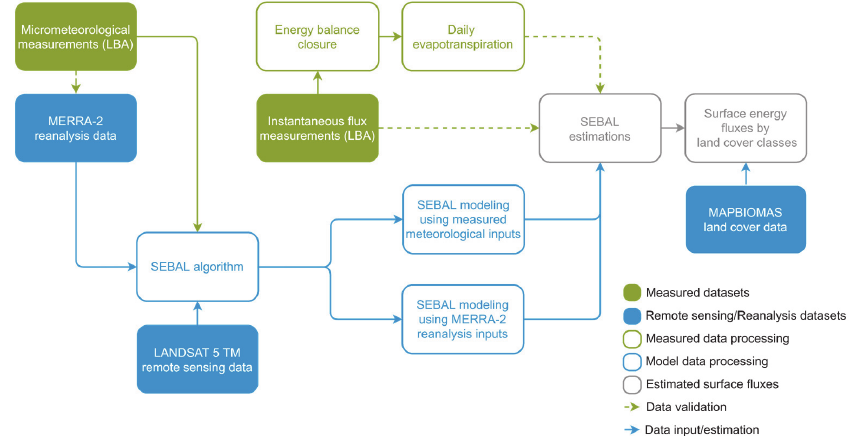
Figure 1. Flowchart of the methodology to estimate surface energy and water fluxes based on meteorological measurements, Modern-Era Reanalysis for Research and Applications version 2 (MERRA-2) reanalysis data, and Landsat 5 remote sensing images.